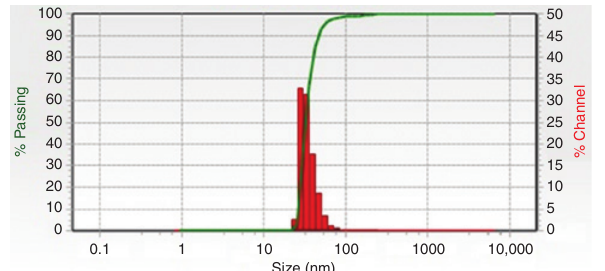
Figure 7: Particle size distribution of the synthesized silver nano- particles (AgNPs) at obtained optimum synthesis conditions.